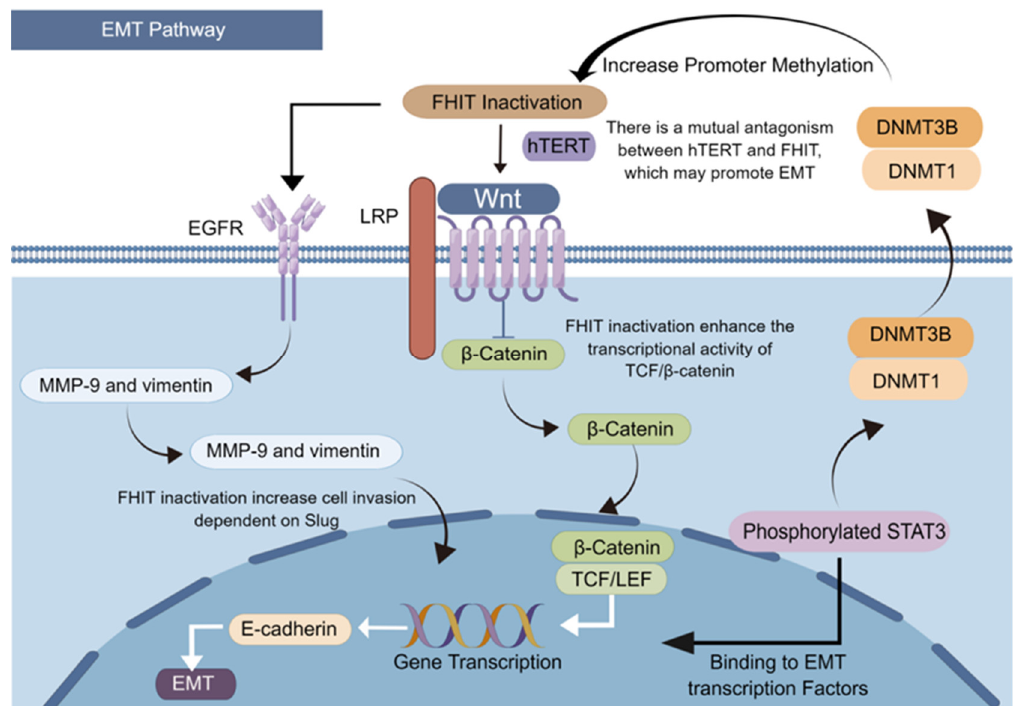
Figure 3. FHIT loss induces epithelial–mesenchymal transition.